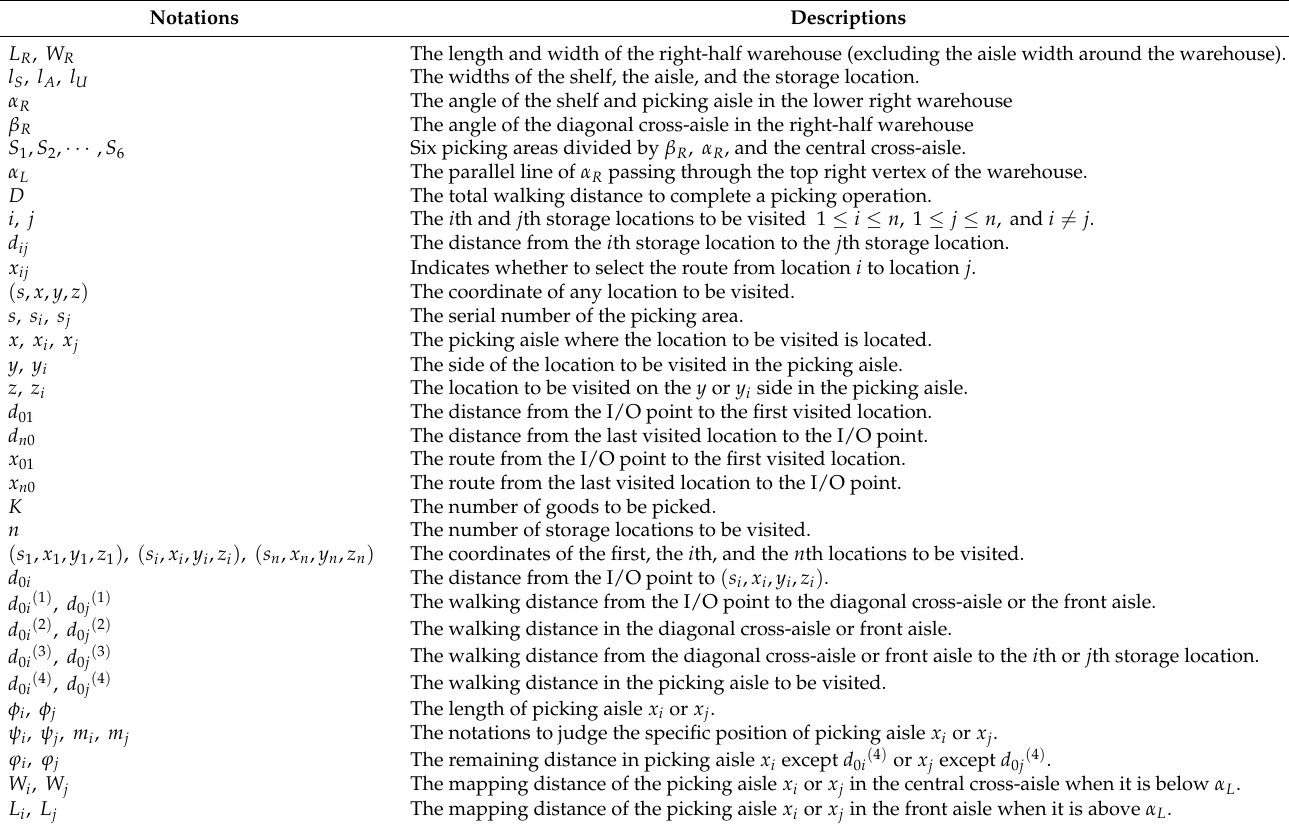
Table 4. Descriptions of the